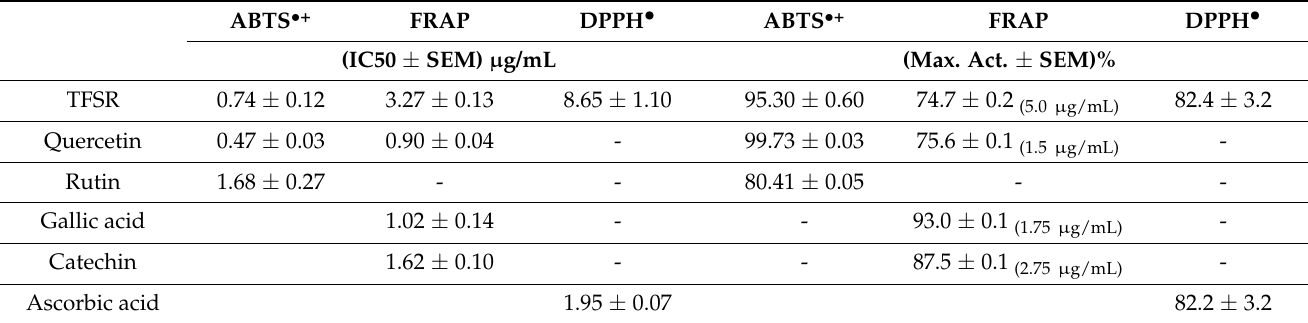
Table 1. Reducing and anti-radical activity of the acetone–water fraction from the stem bark of Stryphnodendron rotundifolium Mart